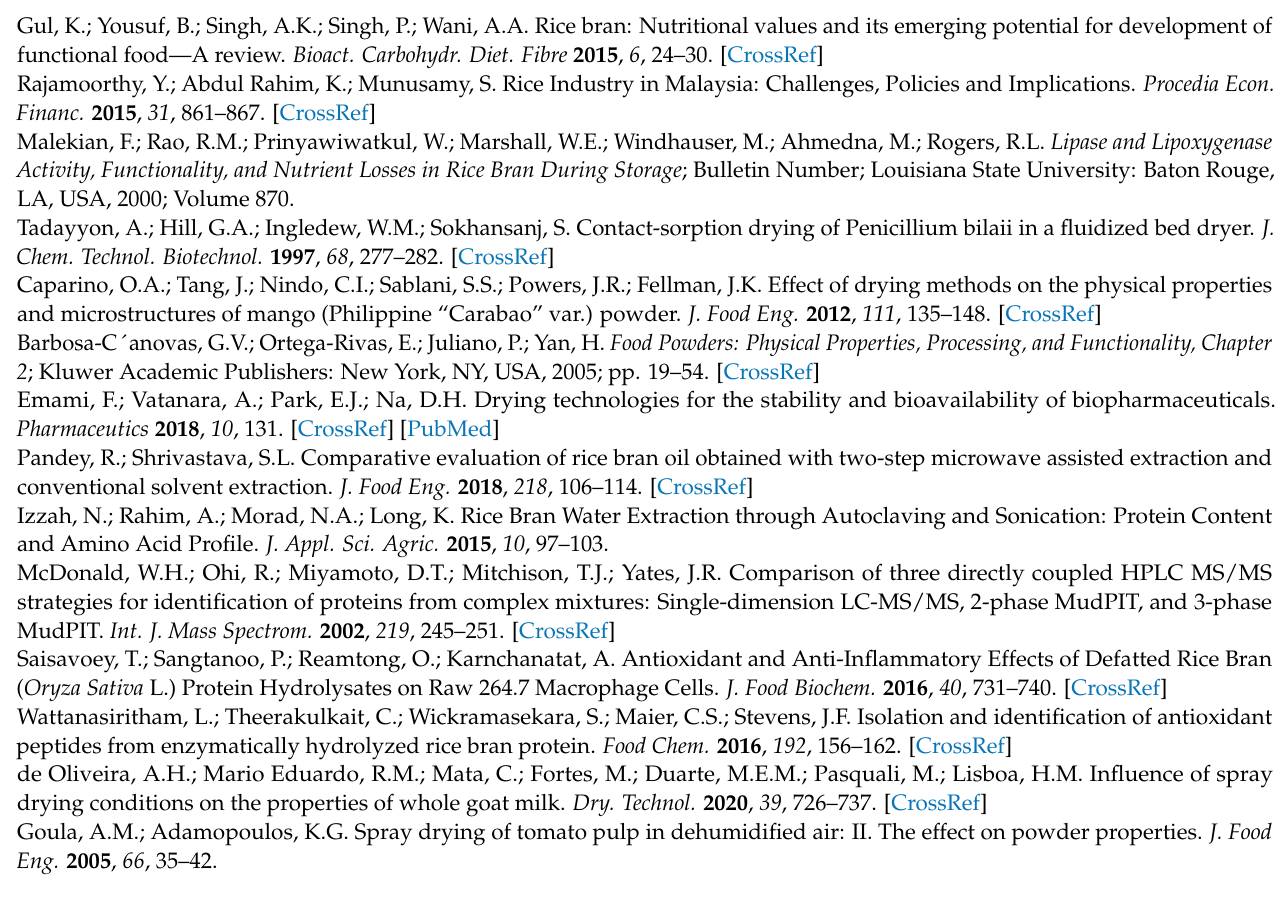
Figure S7 : Fructose-bisphosphate aldolase sequence for rice bran powder